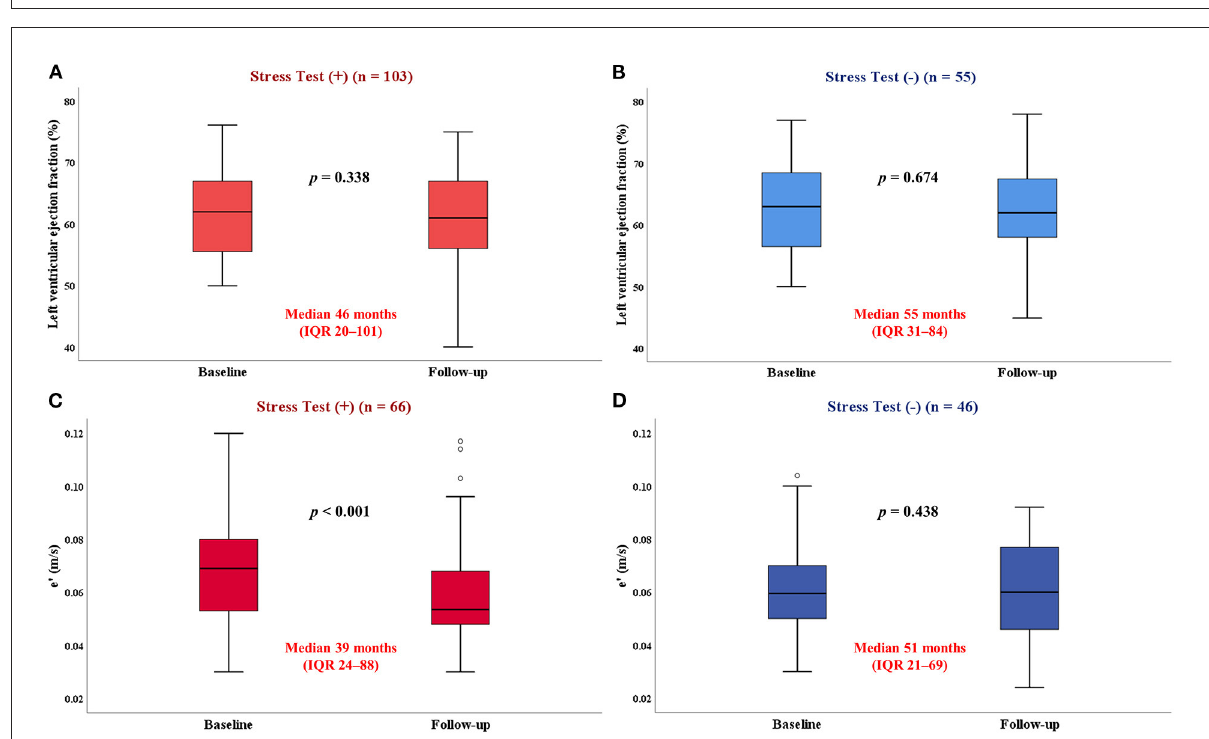
FIGURE3 Impact of stress tests on longitudinal changes in LVEF and e’. LVEF, left ventricular ejection fraction; e’, mitral annulus early diastolic velocity. (A,B) There were no changes in the LVEF according to the results of stress tests. (C,D) HFpEF patients with positive stress tests had a significant decrease of the e’, while there was no significant decrease in those with negative stress